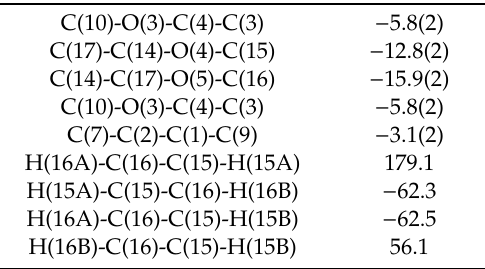
Table 2. Selected dihedral angles [°] for isoflavone compound 6 .